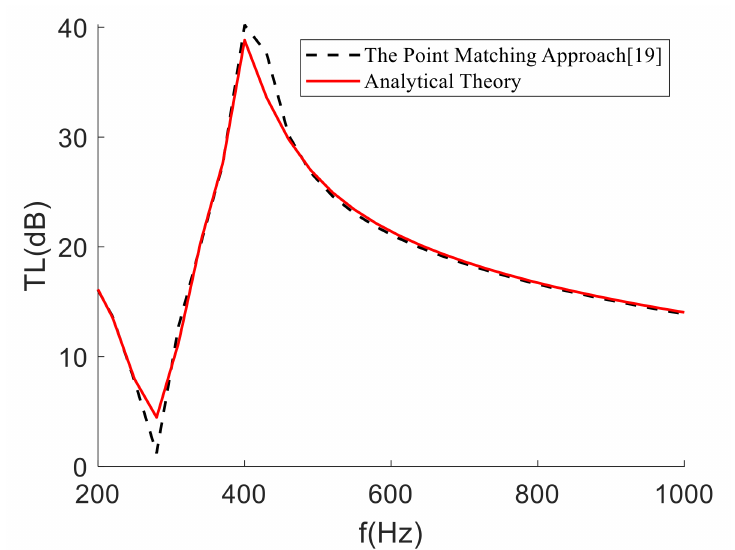
Figure 5. Analytically predicted transmission loss compared with the point-matching method (frequency interval is 30